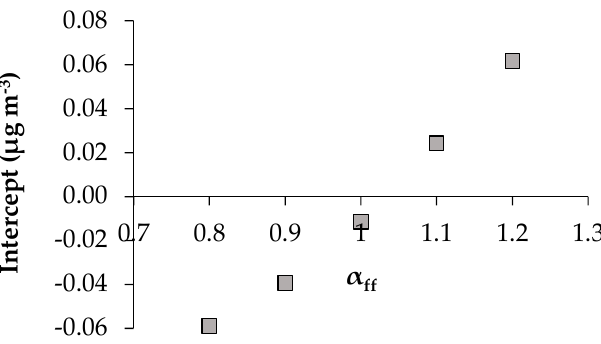
Figure 2. Values of the intercept of the linear regression of 24-h levoglucosan concentrations over respective 24-h mean b abs (950) wb , calculated for different α ff values.